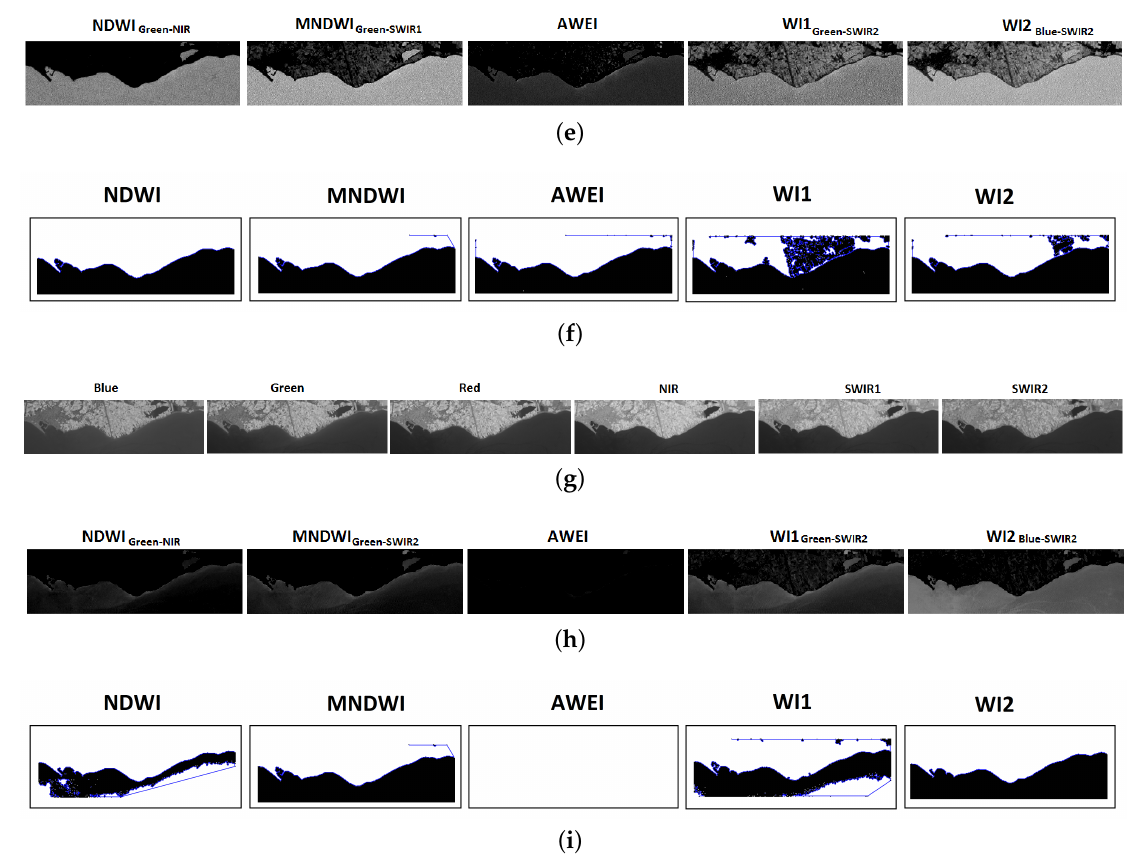
Figure 15. Errors detected after the methodology was applied to the set of 172 images in the Adra River Delta. ( a ) The corrected Landsat band images from 1 June 1987. ( b ) The water indexes calculated from Landsat band images from 1 June 1987. ( c ) The coastline detected from water indexes calculated from a Landsat images (1 June 1987). ( d ) The corrected Landsat image from 4 January 2000. ( e ) The water indexes calculated from Landsat band images from 4 January 2000. ( f ) The coastline detected from water indexes calculated from a Landsat Image (4 January 2000). ( g ) The corrected Landsat image from 22 August 2014. ( h ) The water indexes calculated from Landsat band images from 22 August 2014. ( i ) The coastline detected from water indexes calculated from a Landsat Image (22 August